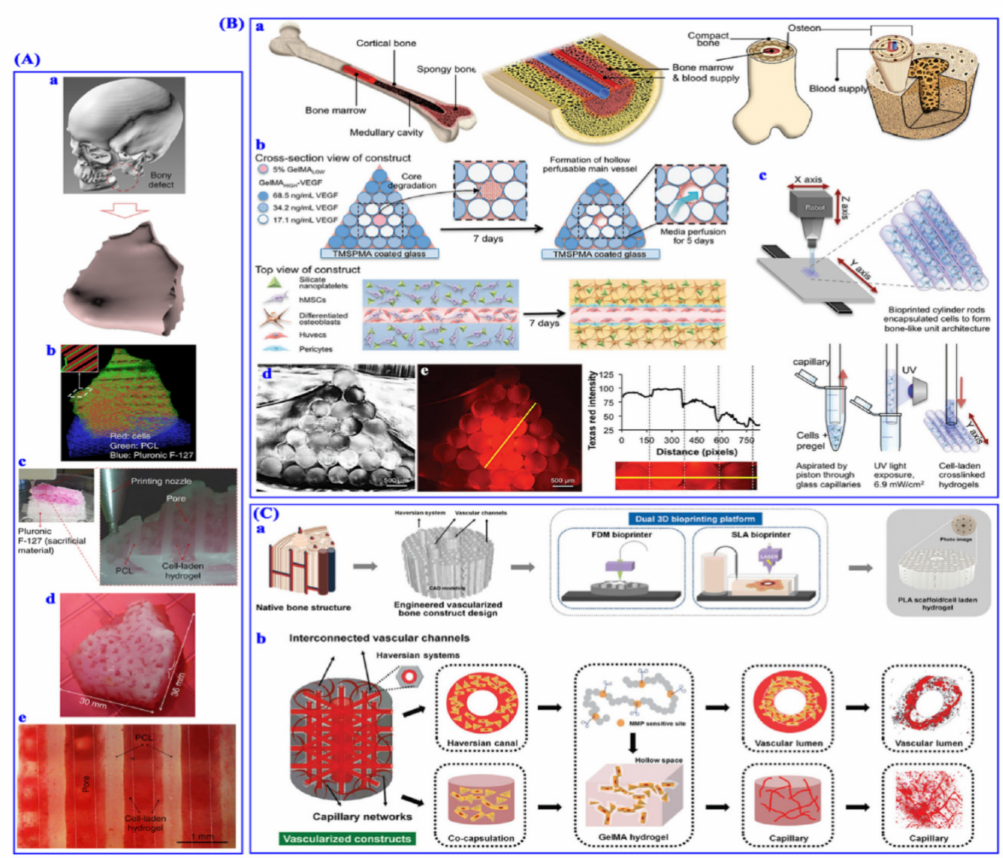
Figure 5. Three-dimensional bioprinting for bone regeneration. ( A ) Reconstruction of mandible bone defect. ( a ) Three- dimensional CAD model from human CT image data. ( b ) Visualized motion program to establish 3D defect architecture. ( c ) 3D bioprinting process with the integrated tissue–organ printer(ITOP) system. ( d ) Picture of the 3D bioprinted